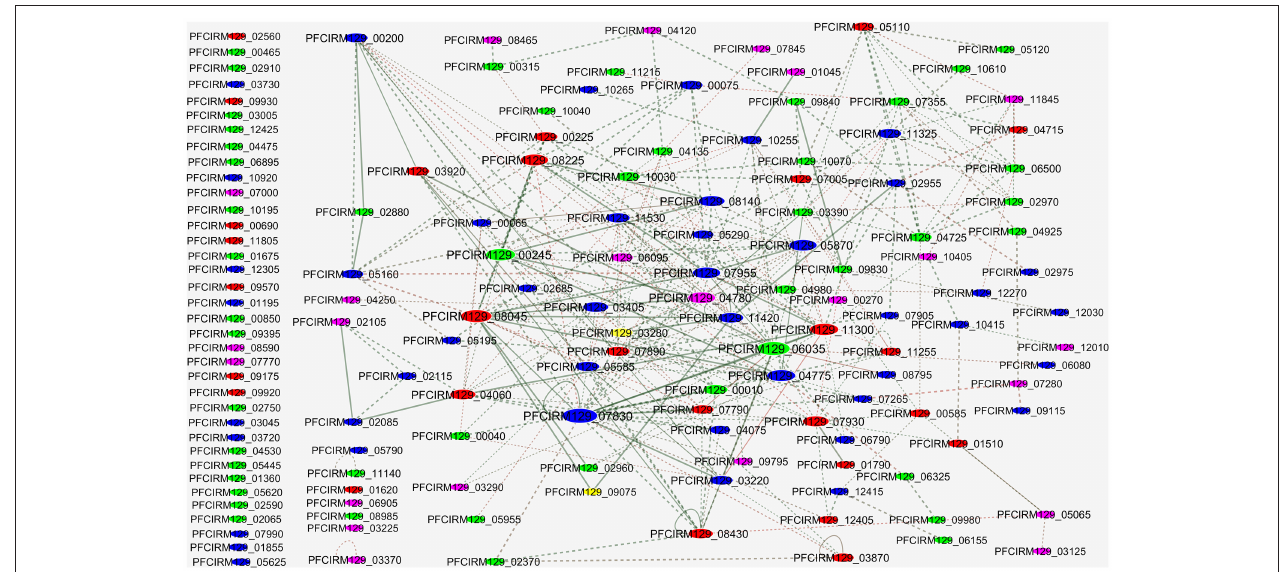
FIGURE 7 | Protein-protein interactions of the proteins identified as differentially expressed in CB 129 1 slpB. The sizes of the nodes represent the degree of interaction for each gene/protein; the major nodes demonstrate greater interactions. Red, up-regulated; Blue, unchanged; Green, down-regulated; Yellow, Exclusive identified at WT strain; Purple, Exclusive identified at CB129 1 slpB